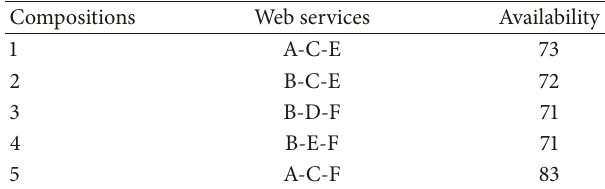
Table 7: Possible compositions from the available web